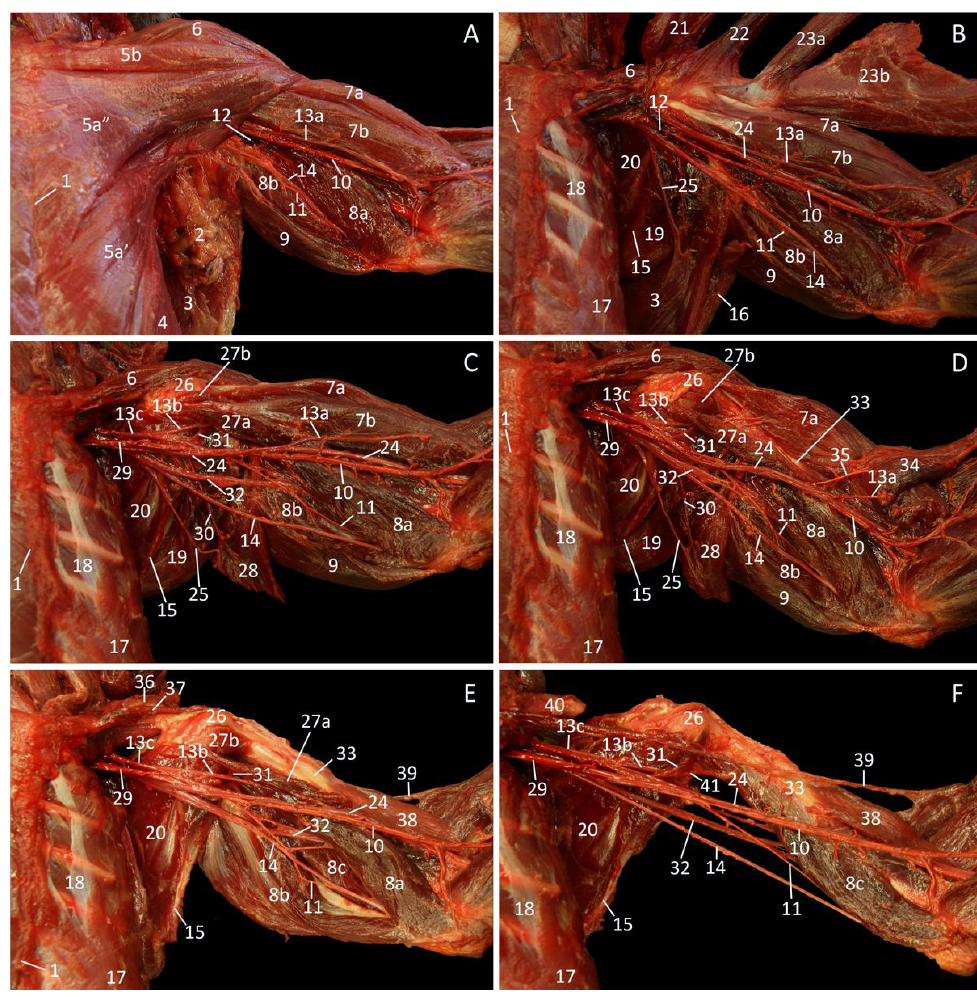
Figure 5. Medial view of the left armpit and upper arm; the arterial system is filled with red latex. ( A ): Superficial layer; ( B ): Second layer, after the m. pectoralis transversus, the m. pectoralis descendens, the m. pectoralis abdominalis, and the m. pectoralis profundus have been retracted, ( C ): Third layer, after detailed preparation of the blood vessels and nerves, and the removal of the mm. pectorales, the m. latissimus dorsi, and the m. cutaneus trunci; ( D ): Fourth layer, after removal of the m. biceps brachii caput breve; ( E ): Fifth layer, after the removal of the m. biceps brachii, the m. cleidodeltoideus, the m. teres major, the m. tensor fasciae antebrachii, and the stump of the m. latissimus dorsi; ( F ): Deepest layer, after the clavicle has been detached from the acromion and the m. triceps brachii caput longum and caput laterale, and the m. coracobrachialis medialis and profundus have been removed.